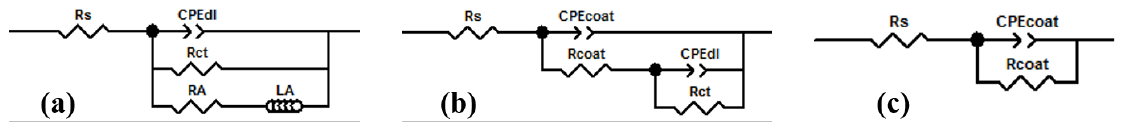
Figure 2. The equivalent electrical circuits used for the fitting of the EIS data: ( a ) magnesium substrate; ( b ) double capacitance loop and ( c ) single capacitance loop. Table 1. The fitting results of EIS shown in Figure